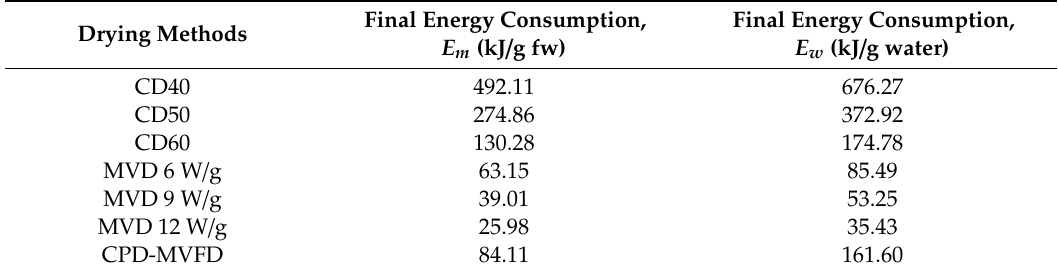
Figure 1. Specific energy consumption of M. koenigii ( a ) in kJ/g fw and in ( b ) kJ/g water for convective hot air drying (CD), microwave vacuum drying (MVD) and microwave vacuum finishing-drying (MVFD) applied after CPD during CPD-MVFD. Table 1. Final specific energy consumption of dried M. koenigii leaves subjected to CD, MVD, and CPD-MVFD.